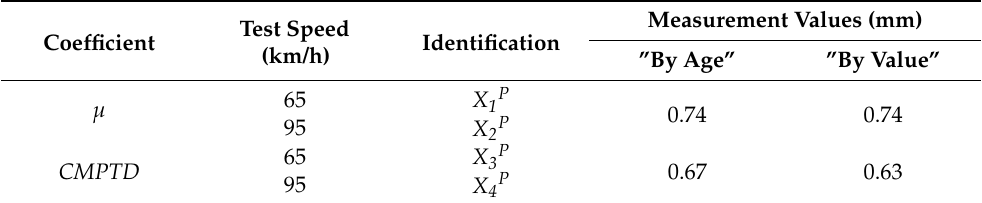
Table 7. Field tests results for asphalt concrete—model II (two speeds together—65 and 95 km/h in one collection).